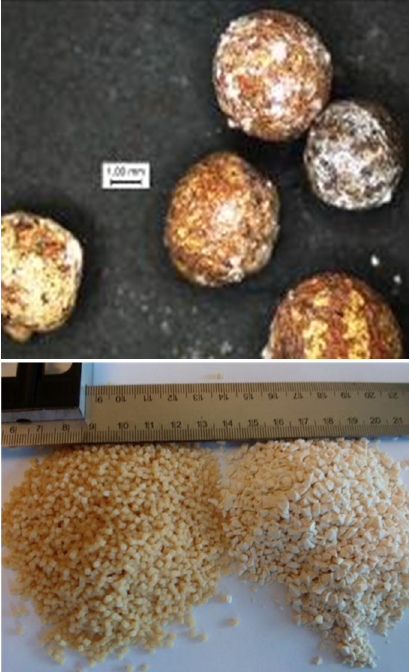
Figure 3. First generation expanded clay based healing agent (top image) and next generation lactate ‐ derivative based healing agent (bottom